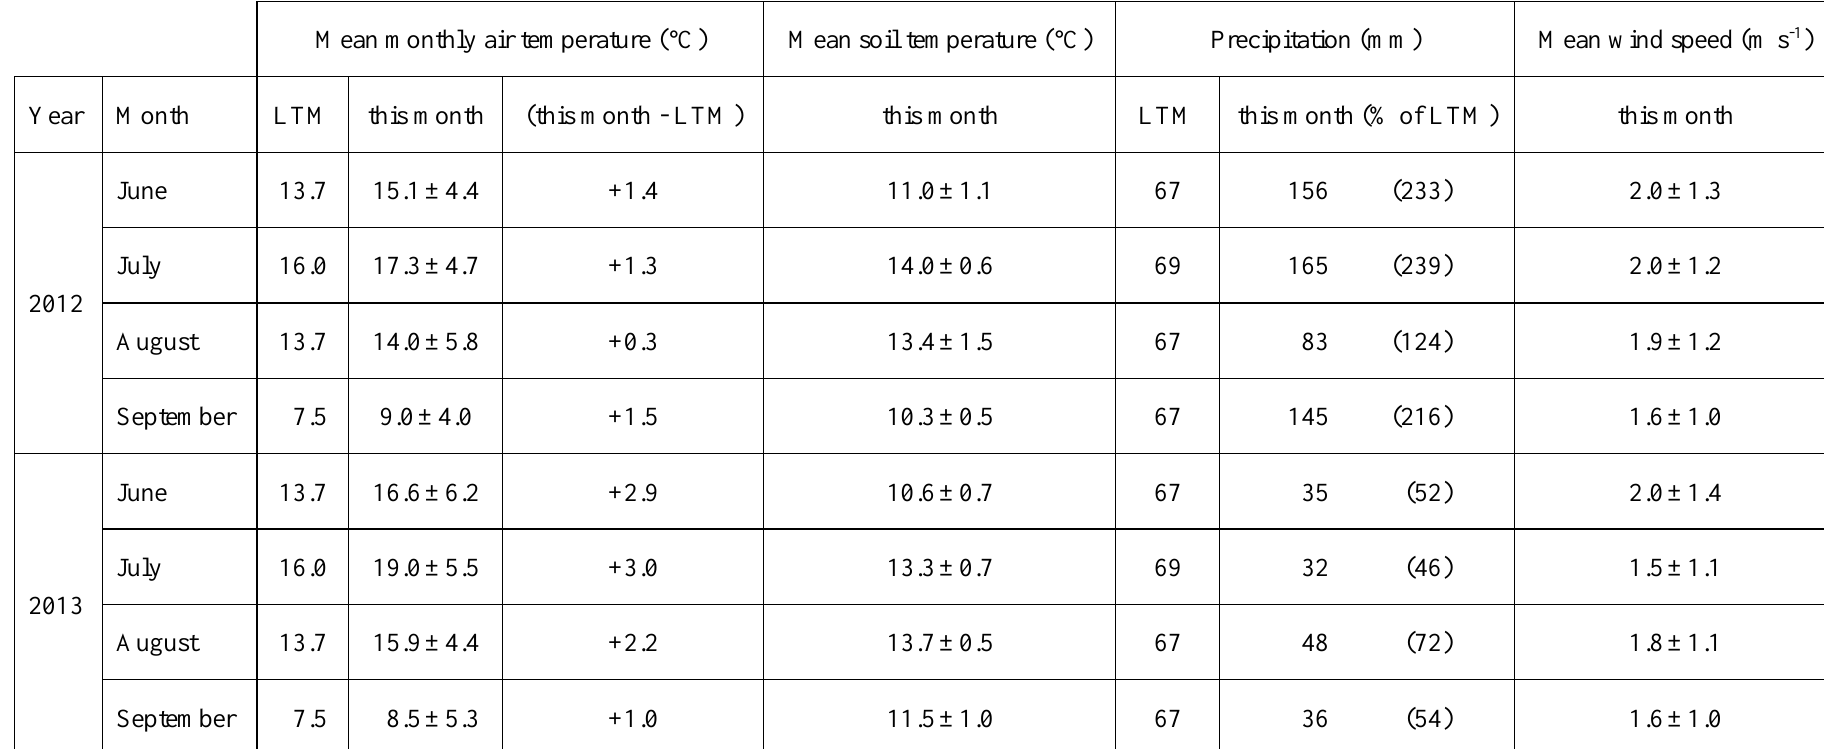
Table 1. Weather conditions (± SD) recorded (mostly) at Medla-Pev-Nyur during the calendar months of June to September in the years 2012 and 2013. Soil temperature was measured at depth 0.3 m. Precipitation data were obtained from the Ust-Vym meteorological station (Centre for Hydrometeorology and Environmental Monitoring of the Komi Republic; 34.5 km north of Medla-Pev-Nur). LTM = long-term mean (1965–2012) value derived from data collected at